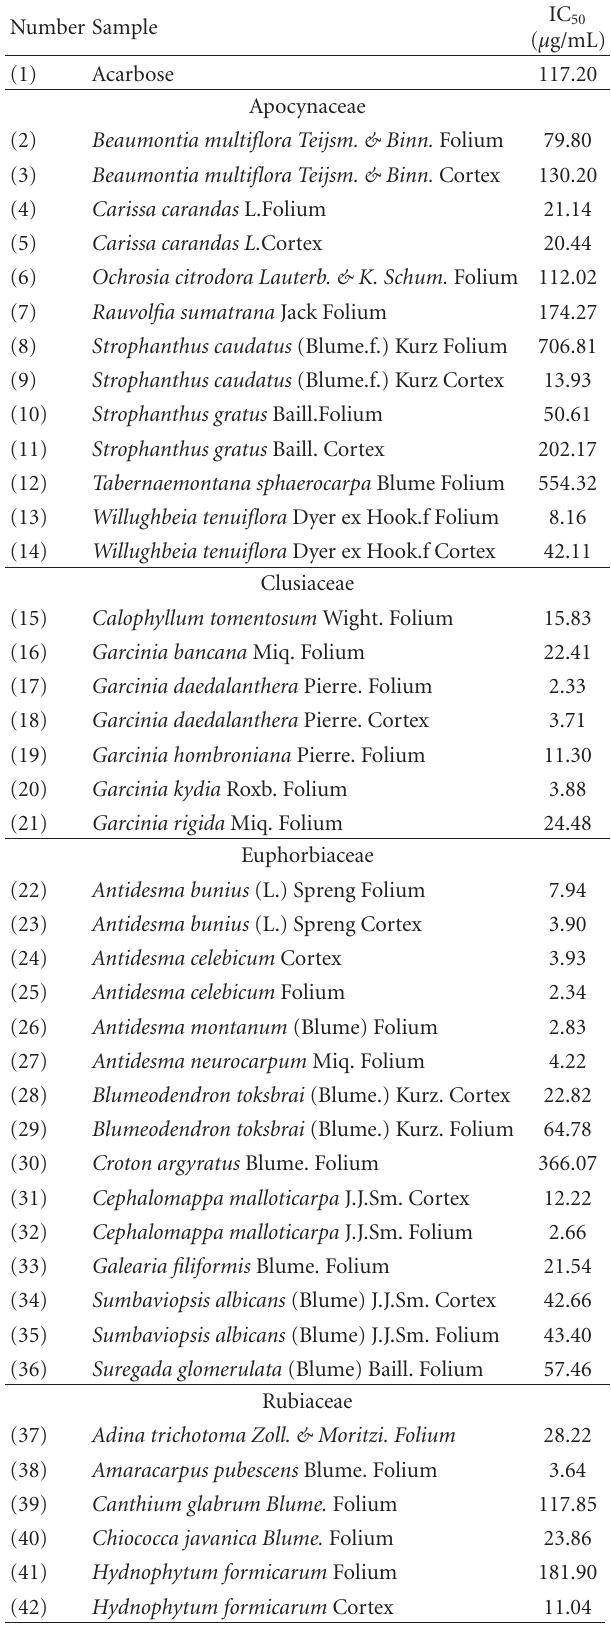
Table 2: IC 50 values of rude extracts against α -glucosidase. Number